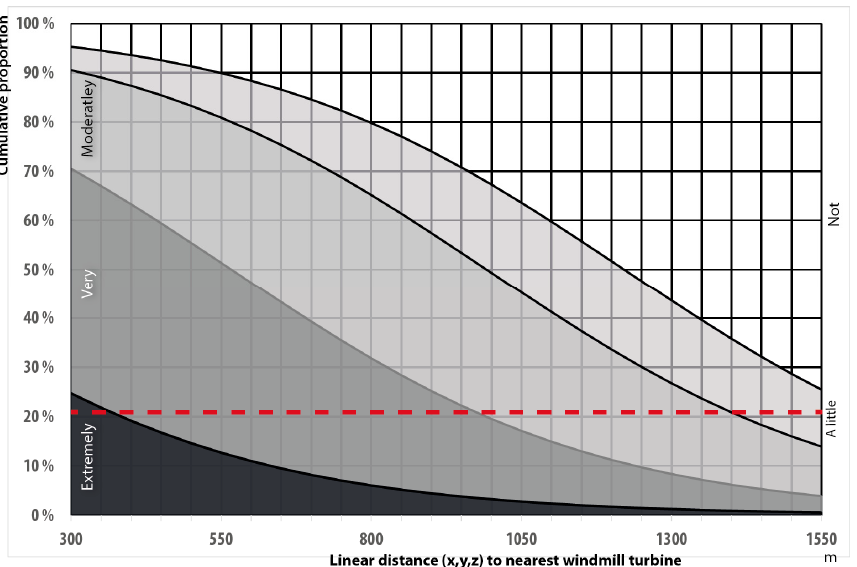
Figure 13. Exposure–effect relationships for annoyance right outside the dwelling from wind turbine noise as a function of linear distance. n = 87.